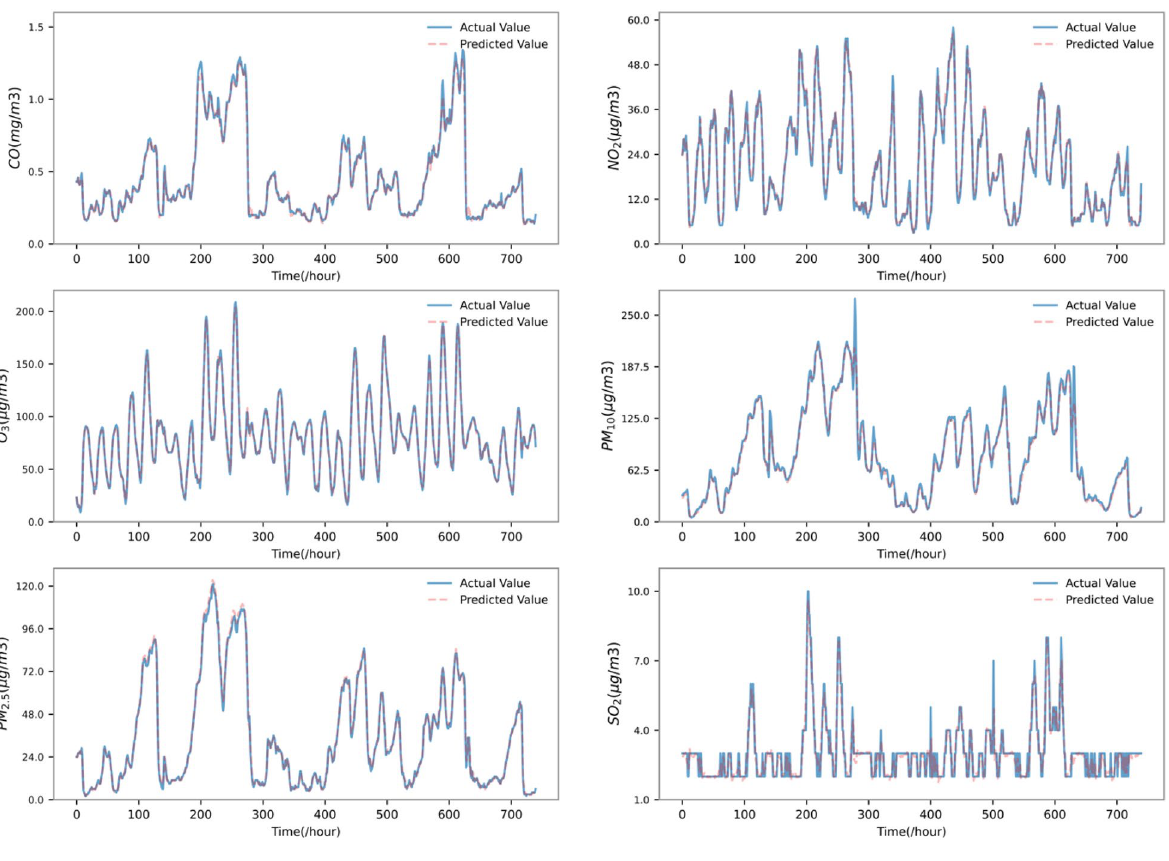
Figure 7. Forecast results of 6 kinds of pollutants.